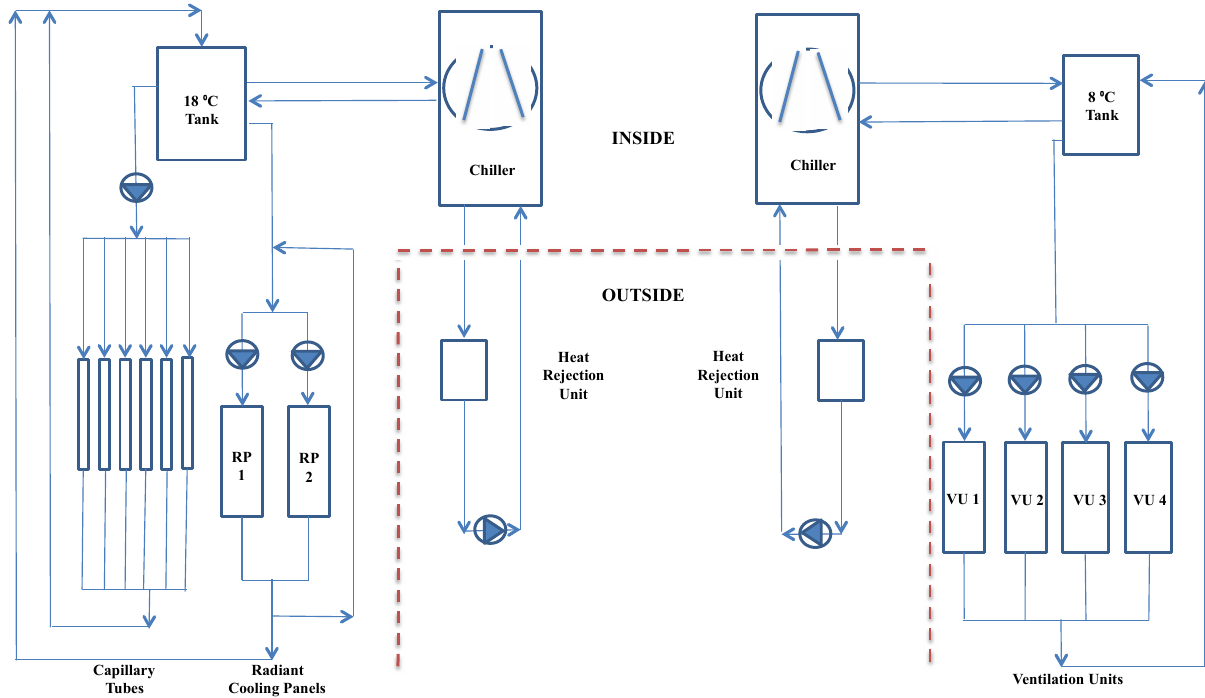
Figure 5. Schematic view of the current hydronic